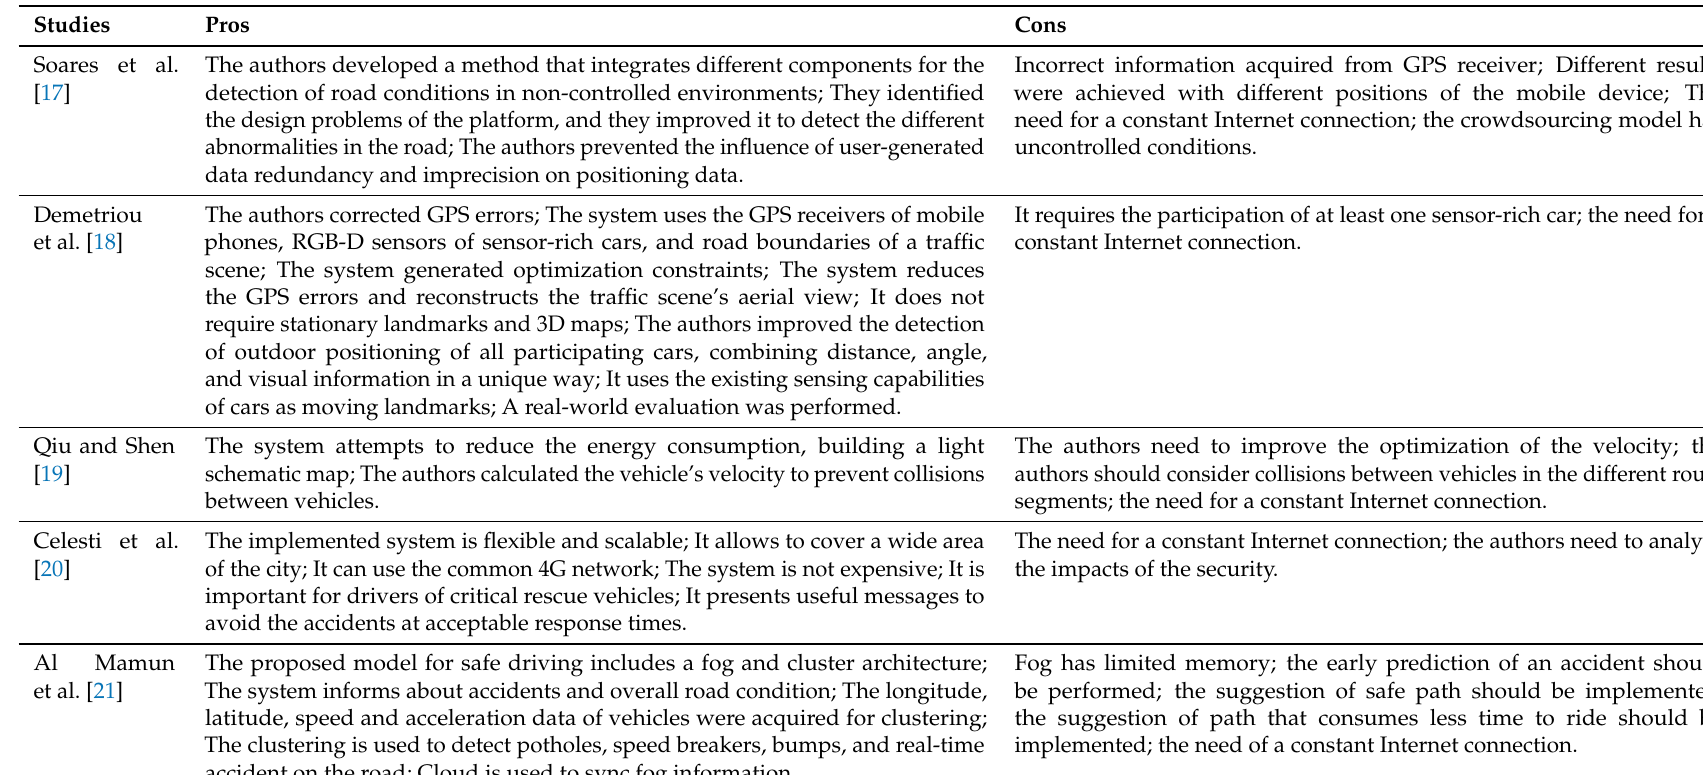
Table 6. Pros and cons of the studies